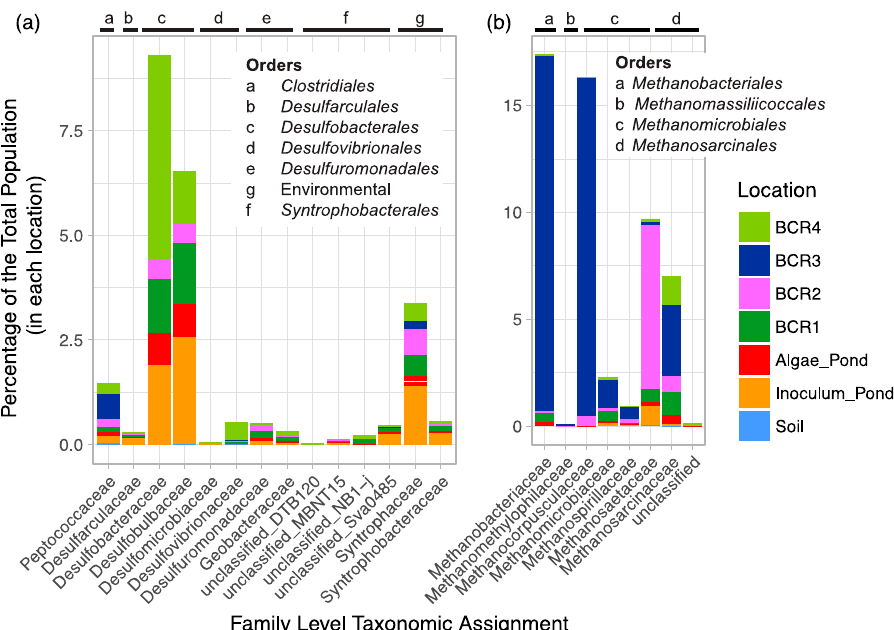
Figure 2. Family-level taxonomic summary diagram of relative abundance of putative ( a ) SRM and ( b ) methanogens in the BCRs and other locations sampled. A phylogenetic comparison of all the samples with respect to their SRM-related genus-level taxa (94% homology cut-off OTUs) was performed using an unweighted UniFrac analysis [36] (Figure 3).